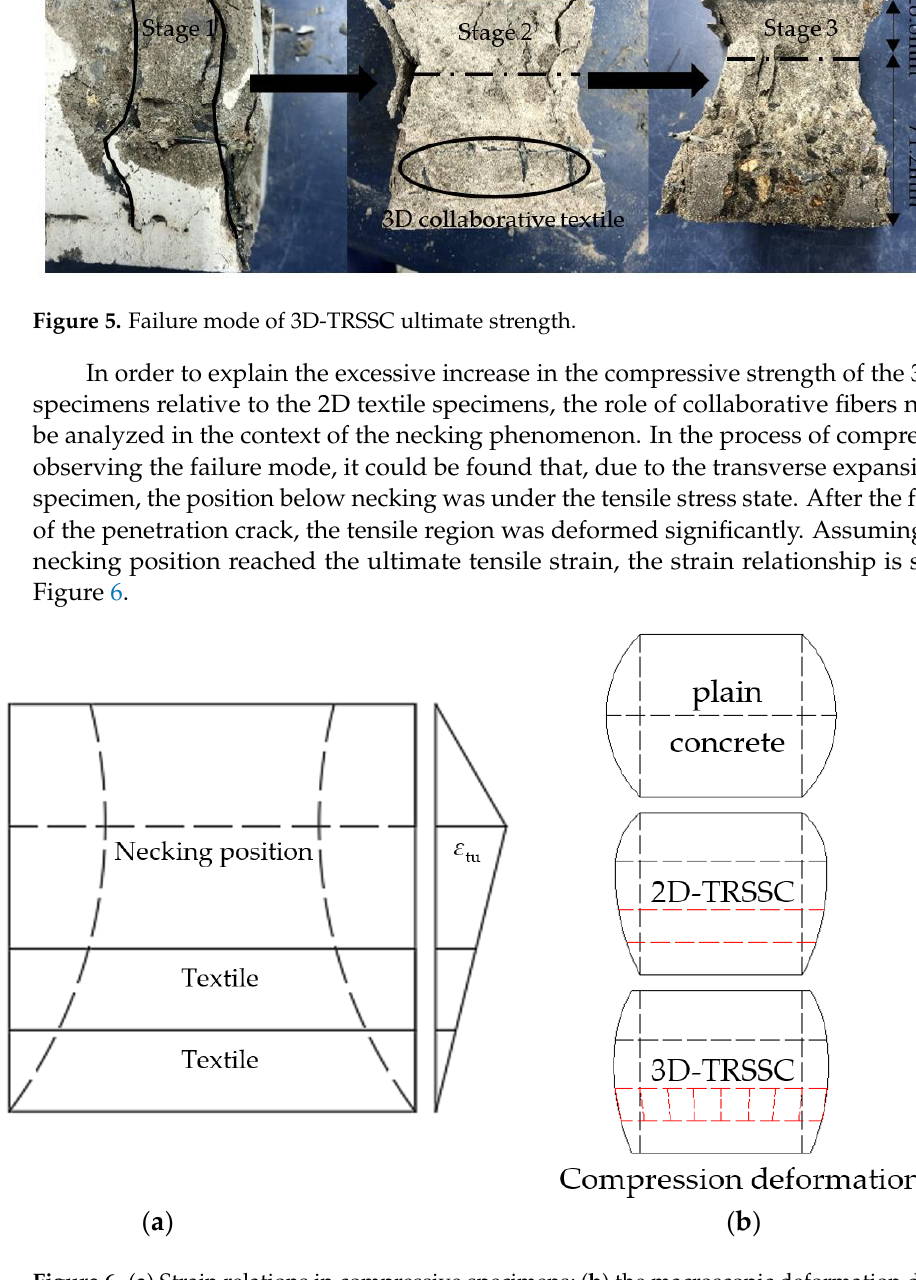
(3) E s : modulus of elasticity of fibers E c : modulus of elasticity of concrete  tu : ultimate tensile strain of concrete t : distance from necking position to the bottom of the specimen D : diameter of fiber bundle, 1 mm In the case of this test, the calculated result was obtained as h 0 = 27.2 mm, and by observing the actual text, h 0 = 28 – 30 mm: the calculated result is in good agreement with the actual situation. The role of collaborative fibers could be analyzed through the defor- mation relationship after the necking position is determined. A certain angle existed in the collaborative fibers because the two layers of textiles were not equally deformed. In addition, the horizontal deformation of each section of the whole specimen could be ob- tained by calculating the necking position, and the stresses in the two layers of the textile would be adjusted as shown in Figure 7.